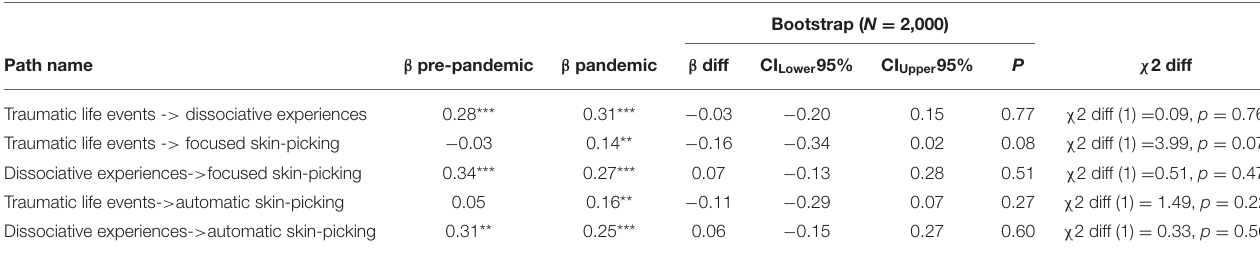
TABLE 3 | Multi-group analysis: difference between paths in mediation model.